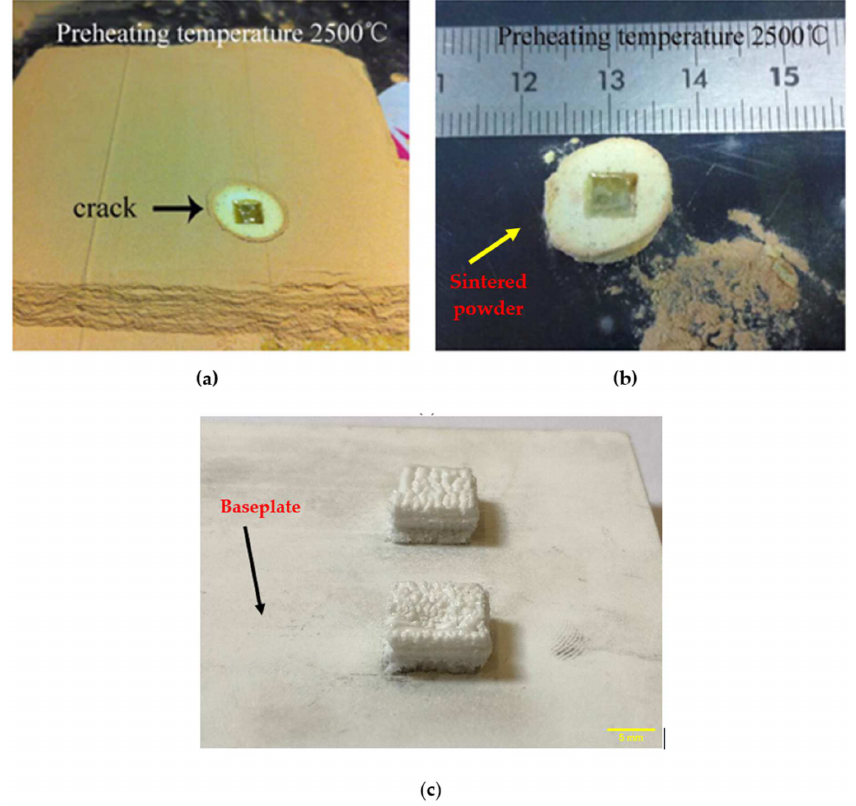
Figure 18. ( a ) In a powder bed YSZ sample printed using the preheating system developed by Liu et al. [37] (republished with permission). ( b ) Removed from powder bed, YSZ sample printed using the preheating system developed by Liu et al. [37] (republished with permission). ( c ) Sample printed using the preheating system developed in this study before removing from the